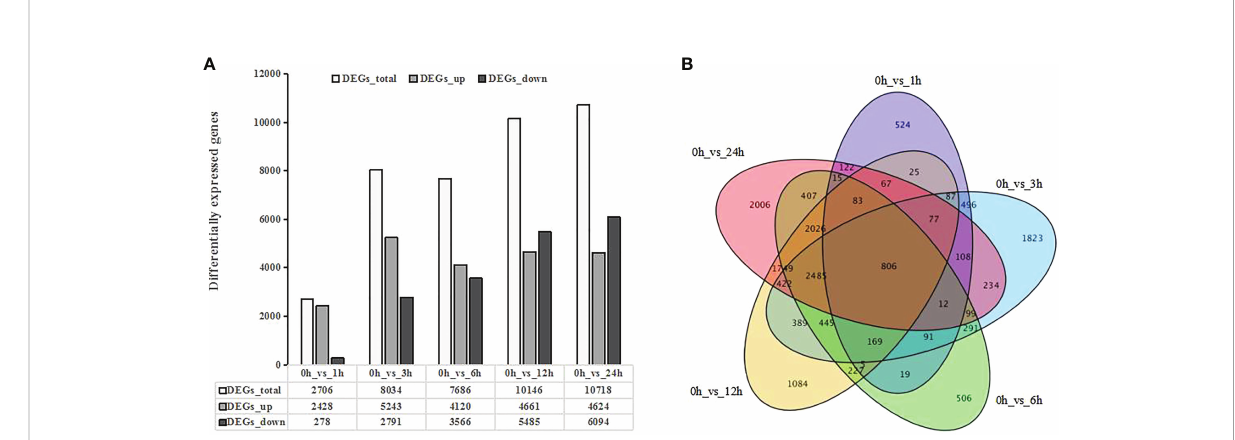
FIGURE 1 Differentially expressed genes (DEGs) in response to UV-B treatment in blueberry revealed by transcriptome deep sequencing (RNA-seq). (A) Number of DEGs in response to UV-B. DEGs_up, upregulated DEGs; DEGs_down, downregulated DEGs. (B) Venn diagrams showing the extent of overlaps between DEGs across pairwise comparisons. Purple, DEGs for 0 h vs 1 h; blue, DEGs for 0 h vs 3 h; green, DEGs for 0 h vs 6 h; yellow, DEGs for 0 h vs 12 h; and pink, DEGs for 0 h vs 24 h Q-value <